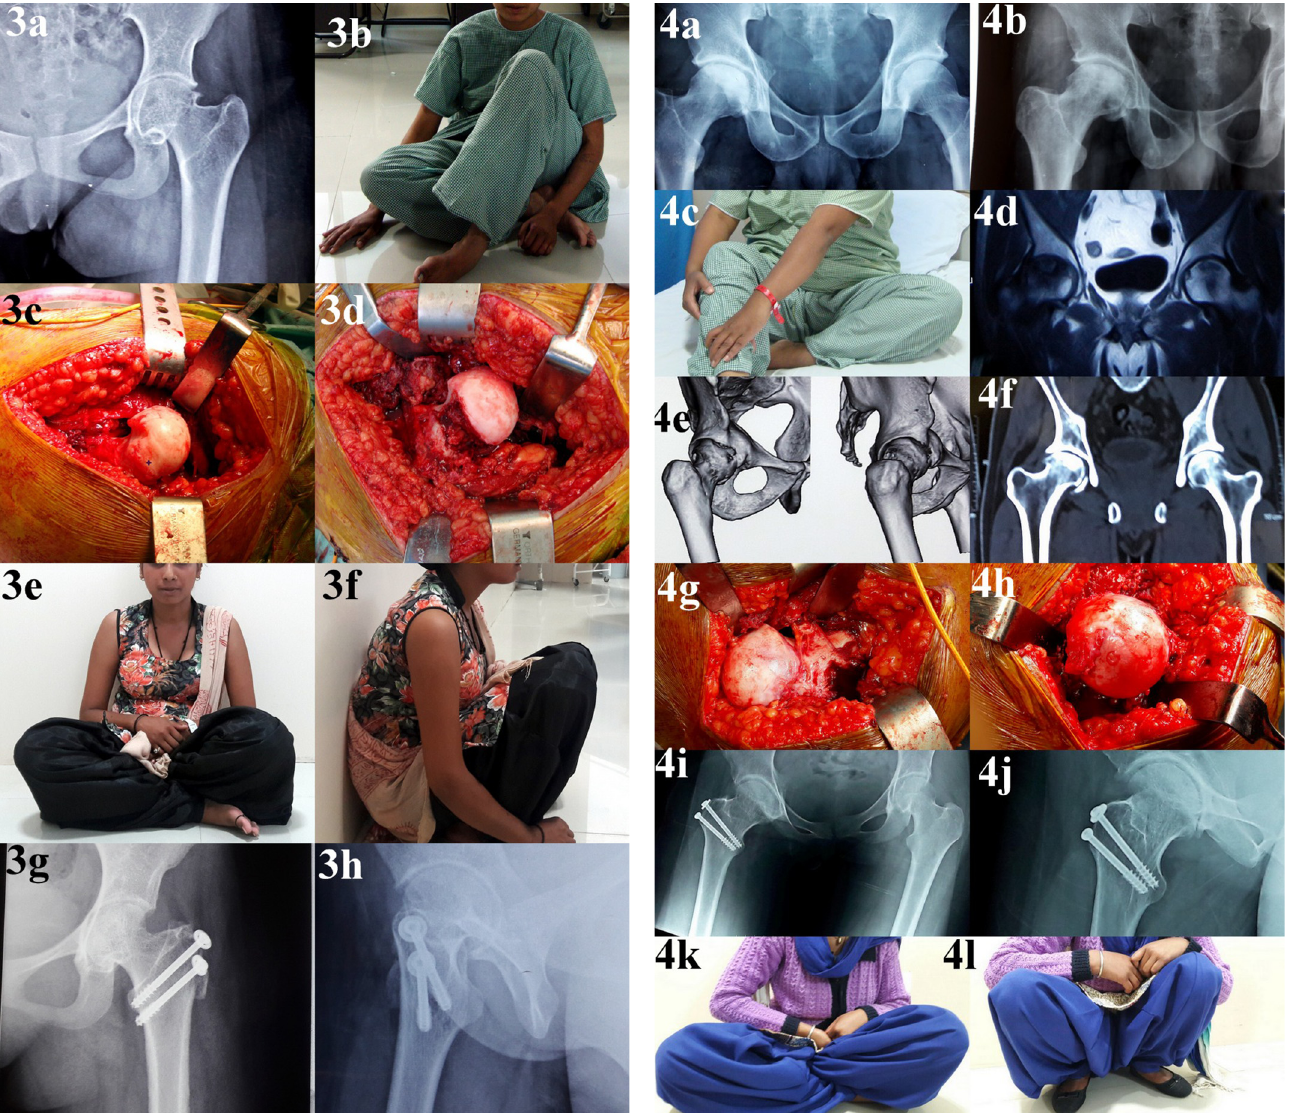
Figure 3. Details of a 27-year-old lady with idiopathic ONFH: panel a: preoperative radiograph showing cam deformity at femoral head – neck junction; panel b: she presented with painful restriction of fl exion and internal rotation; panel c: intraopera- tive picture showing a large cam deformity. Femoral head cartilage looks normal; panel d: intraoperative image after femoral of cam deformity; panels e and f: follow-up pictures showing near normal hip range of motion. Floor-level activities such as squatting and sitting cross-legged are restored; panels g and h: post-operative radiograph showing normal appearing joint after removal of cam deformity.